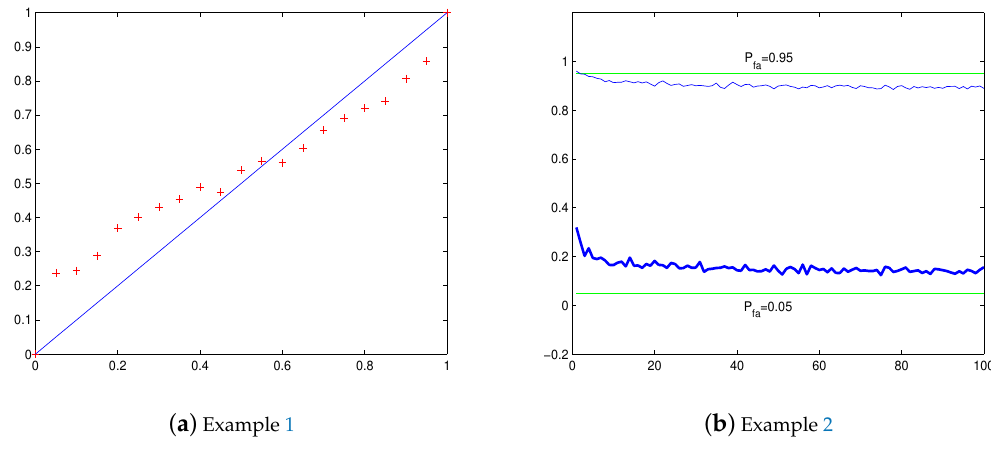
Figure 2. Plots of Examples 1 and 2. ( a ) Average false alarm probability ˆ P fa > P fa vs. P fa = 0,0.05, . . . ,1. ( b ) ˆ P fa vs. M = N = 1,2, . . .